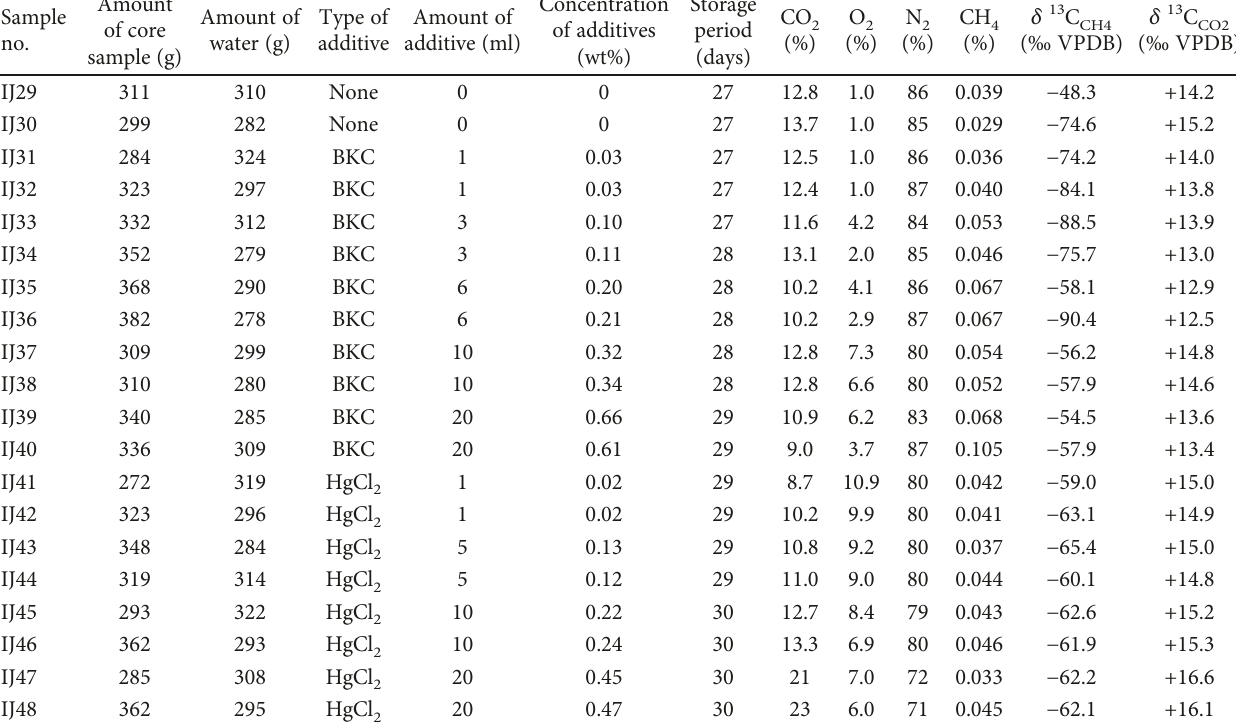
Table 2: Information on IsoJar ™ samples and analytical results of headspace gases for Section 3.1.2.